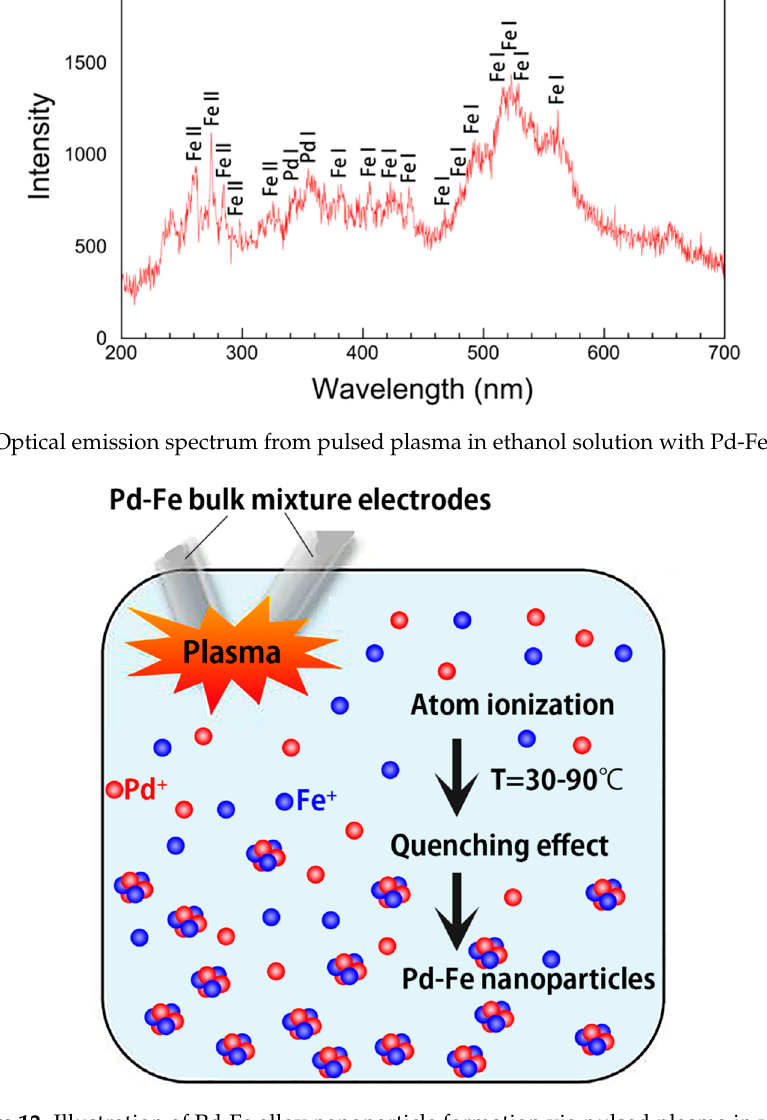
Figure 12. Illustration of Pd-Fe alloy nanoparticle formation via pulsed plasma in water.